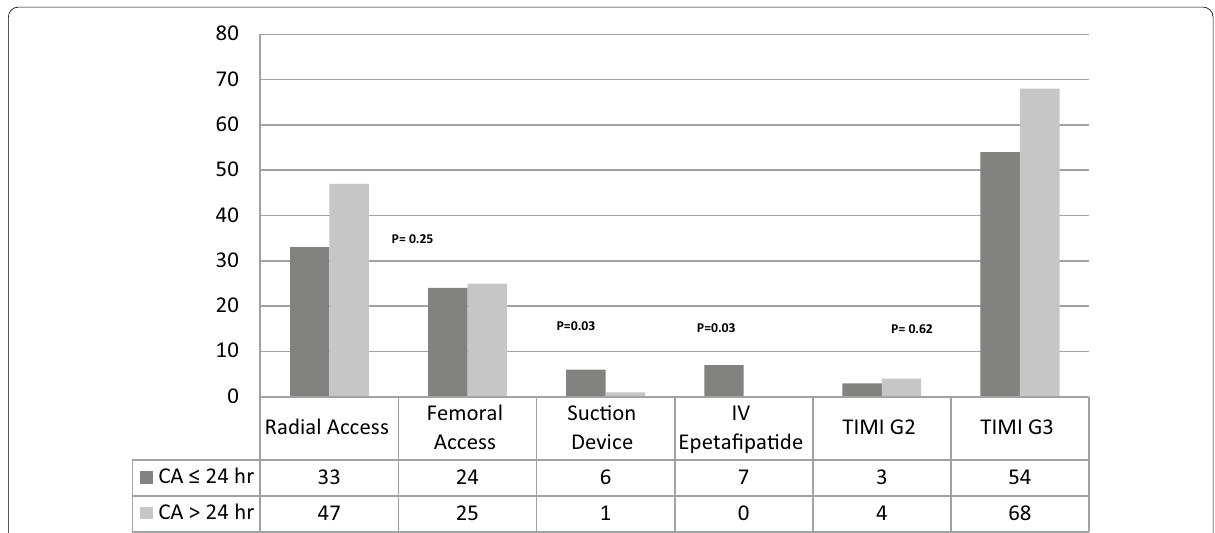
Fig. 1 Procedural data. This chart is representing number of patients who had Radial and femoral access, suction devices and IV Eptifibatide and TIMI flow final results in each group